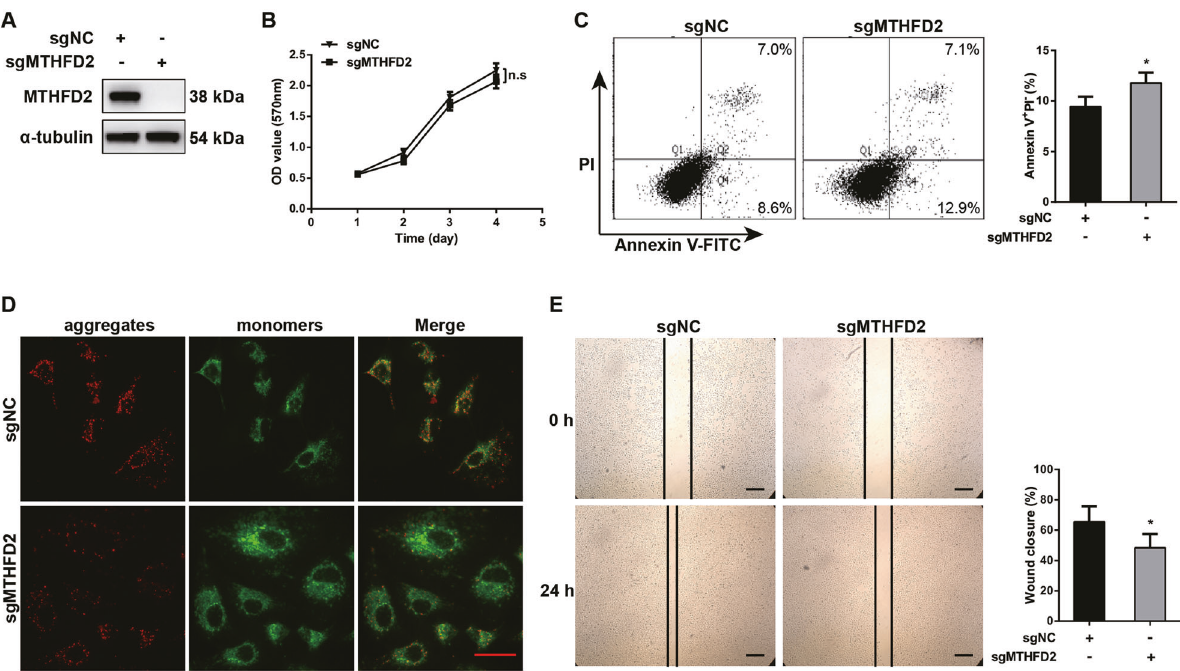
Fig. 3 CRISPR/Cas9-mediated MTHFD2 deletion on A549 cell proliferation, apoptosis and migration. A Western blot con fi rmed the knockout ef fi ciency of MTHFD2 in A549 cells transfected with the sgRNA and negative control. B MTT assay showed the cell proliferation in MTHFD2-knockout cells. C FACS analysis detected the cell apoptosis in MTHFD2-knockout A549 cells. The percentages of cell apoptosis (PI - / Annexin V + ) were quanti fi ed at the right histogram. D JC-1 staining showed the mitochondrial membrane potential ( Δ ψ m) in